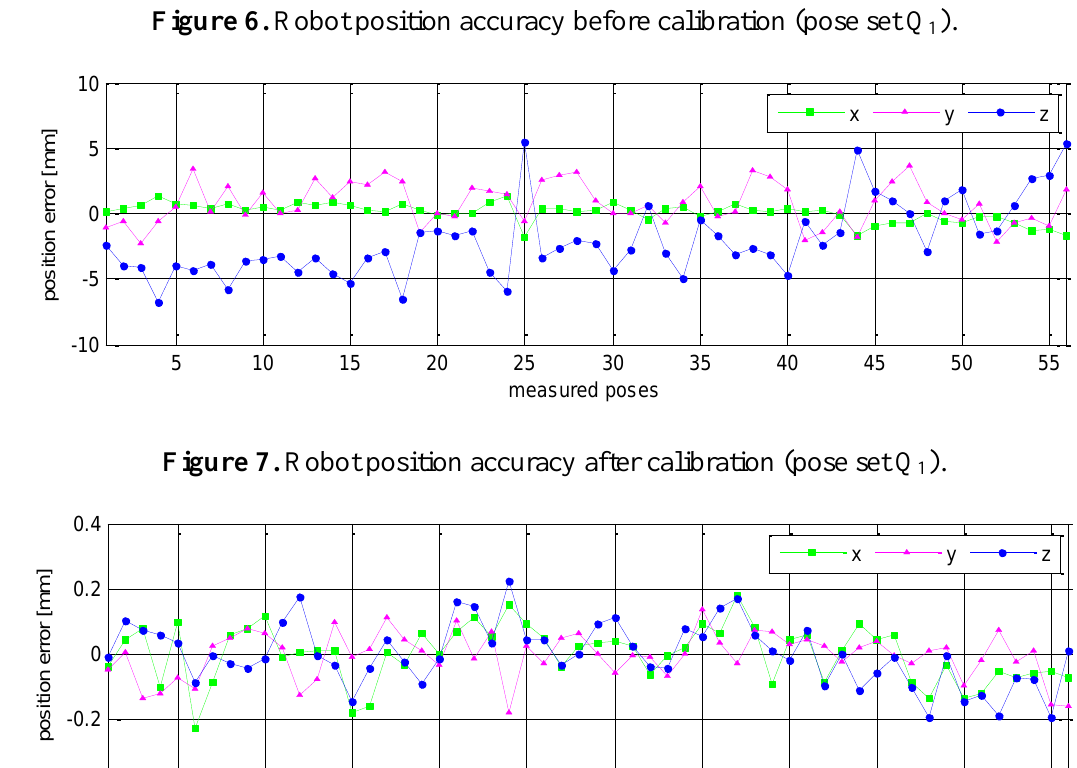
Figure 6. Robot position accuracy before calibration (pose set Q